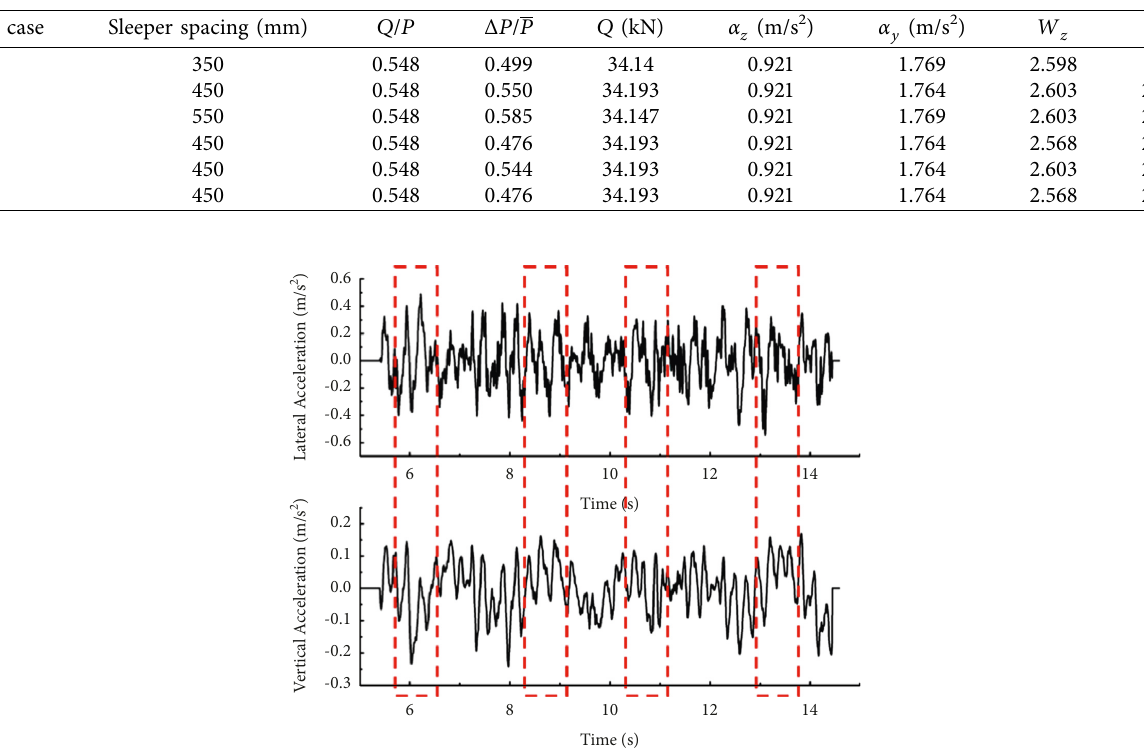
Table 6: Evaluation indexes of the vehicle in different load cases.